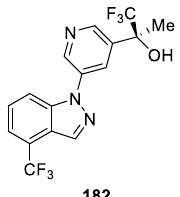
Figure 60. Chemical structure of 1 H -indazole derivative 182 .